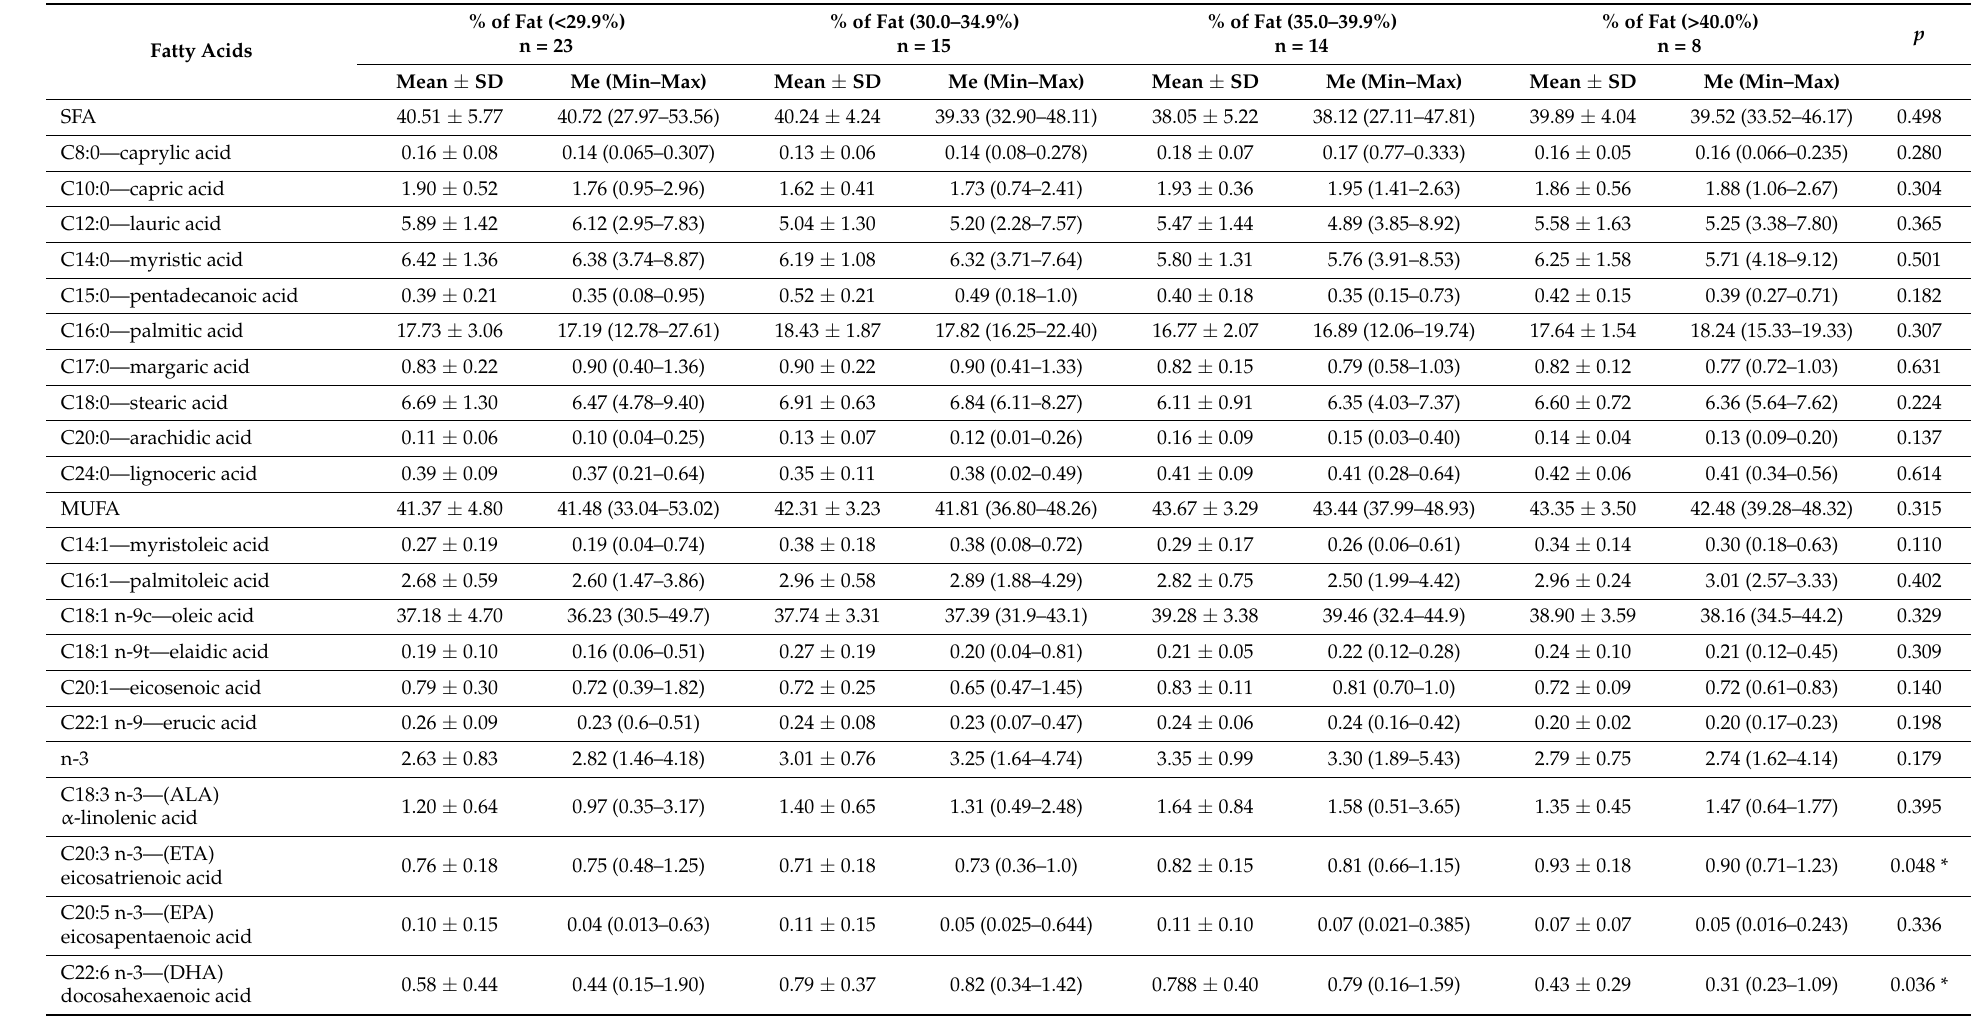
Table 6. Fatty acid content of breast milk (g/100 g of total FA) depending on the amount of body